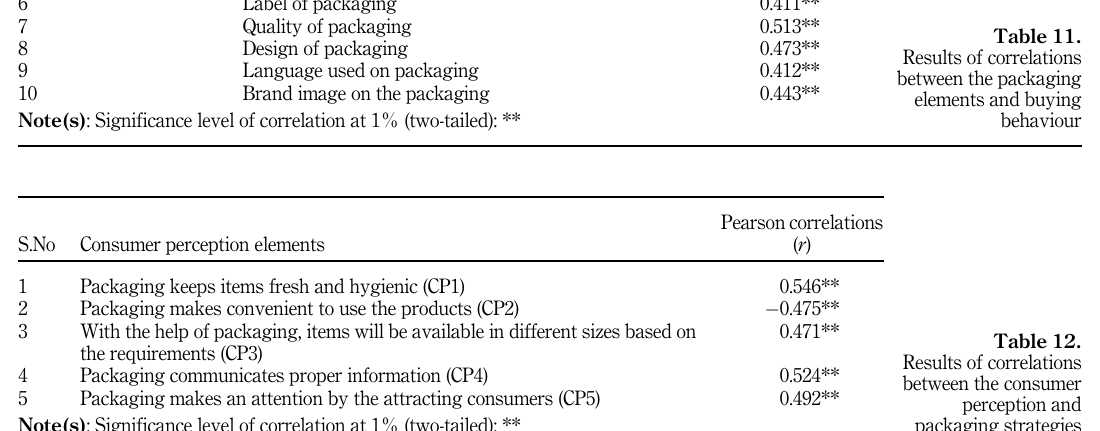
Table 11. Results of correlations